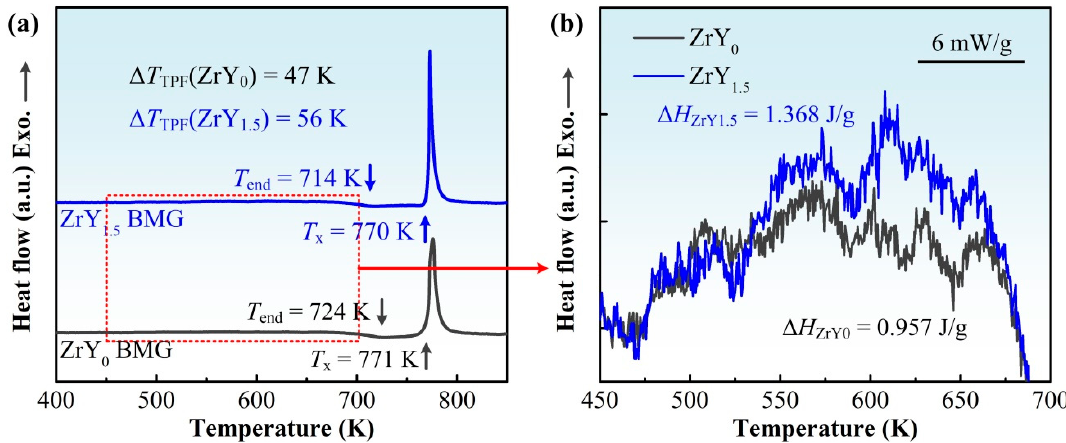
Figure 3. Thermodynamic properties of the as-cast ZrY 0 BMG and ZrY 1.5 BMG: ( a ) DSC curves of the two BMGs; ( b ) the structural relaxation below the glass transition temperature.